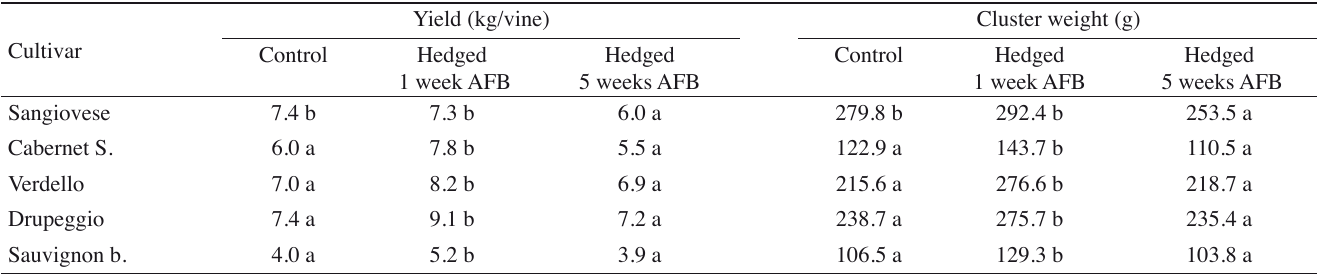
Table 5 - Yield and average cluster weight at harvest in vines of different grapevine cultivars hedged one and five weeks after full bloom (AFB) and control (n= 60)